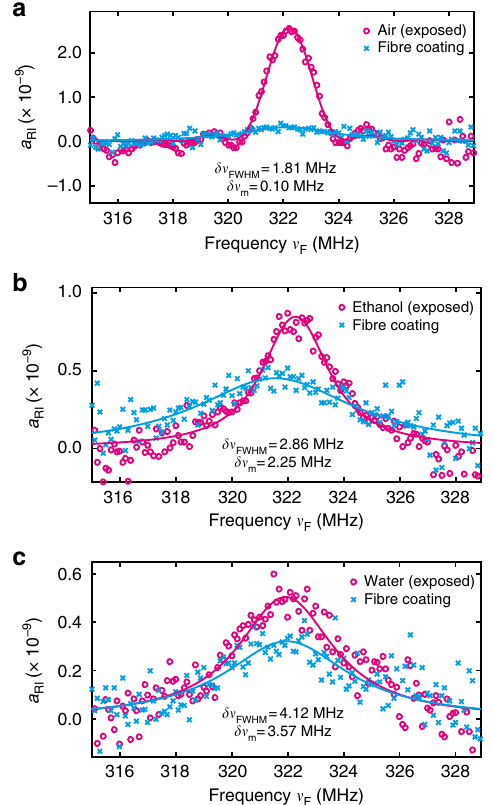
Fig. 7 Spectra of forward stimulated Brillouin scattering at the sensing point. The spectra of forward stimulated Brillouin scattering (FSBS) measured at a given fi bre position inside the 30m fi bre segment (magenta) exposed to a air, b ethanol, and c water. The FSBS spectra measured at an arbitrary position in the normal coated fi bre segment (with acrylate polymer coating) are plotted in cyan. δν FWHM is the full width at half maximum (FWHM) of the measured spectrum at the sensing point (convolution of the pulse spectrum and FSBS resonance spectrum) and δν m is the recovered original linewidth of FSBS resonance at the corresponding